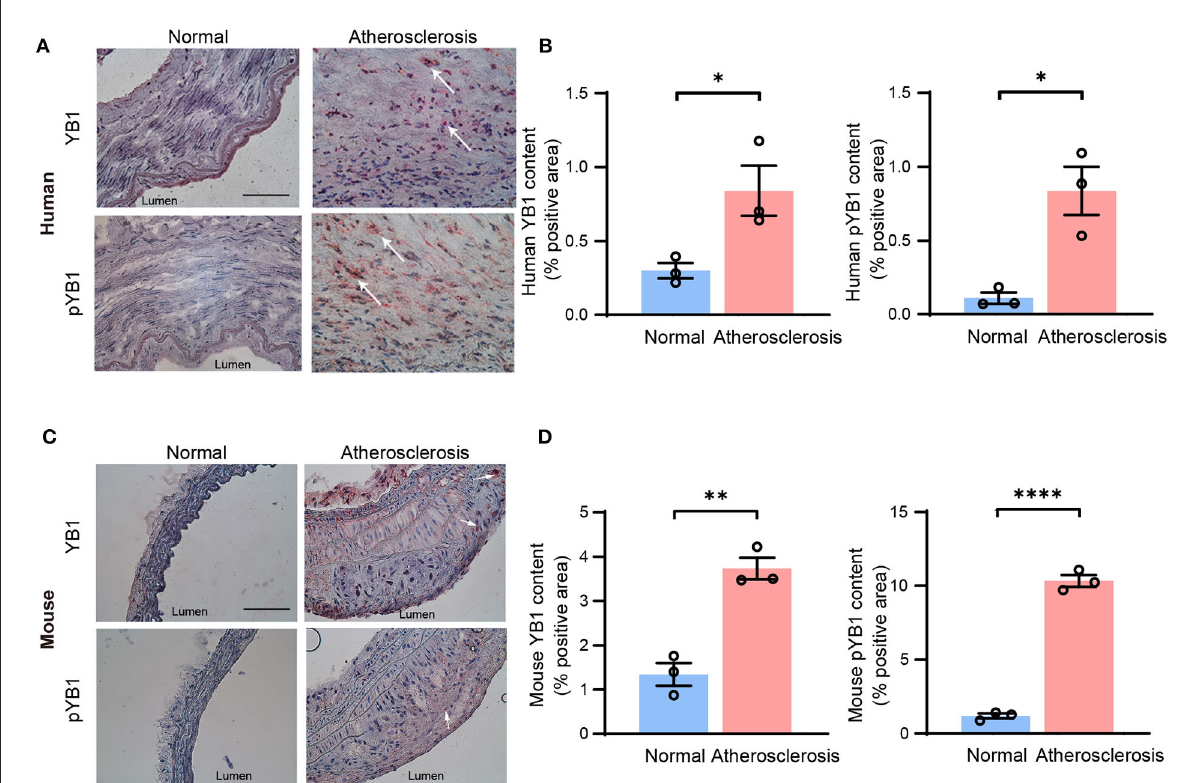
FIGURE2 The expression of YB1 and phosphorylated YB1 were elevated in atherosclerosis. (A) Representative immunohistochemical staining image of YB1 and pYB1 in the human aorta, and the related quantitative analysis (B) . (C) Representative immunohistochemical staining images of YB1 and pYB1 in the aortic arch of ApoE − / − mice, and the related quantitative analysis (D) . Data are presented as the mean ± SEM. Student’s two-tailed t- test. * P < 0.05, ** P < 0.01, **** P < 0.0001 vs. Normal group. Scale bar = 100 µ m ( n = 3 for each